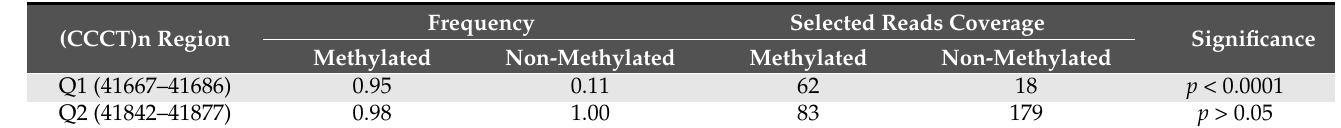
Table 2. Deletions in the methylated/non-methylated regions of simple repeats Q1 and Q2. The frequencies were counted from the total number of deletions. To assess the correlation of these deletions with methylation status, we selected only the reads that covered entire Q1 or Q2 regions plus 5 nucleotides upstream and downstream.